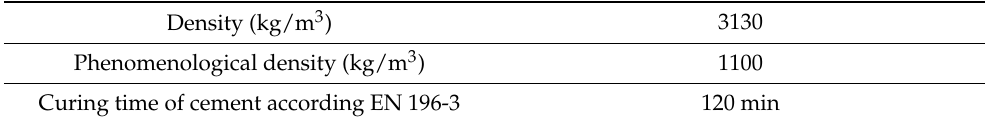
Table 2. Physical characteristics of white